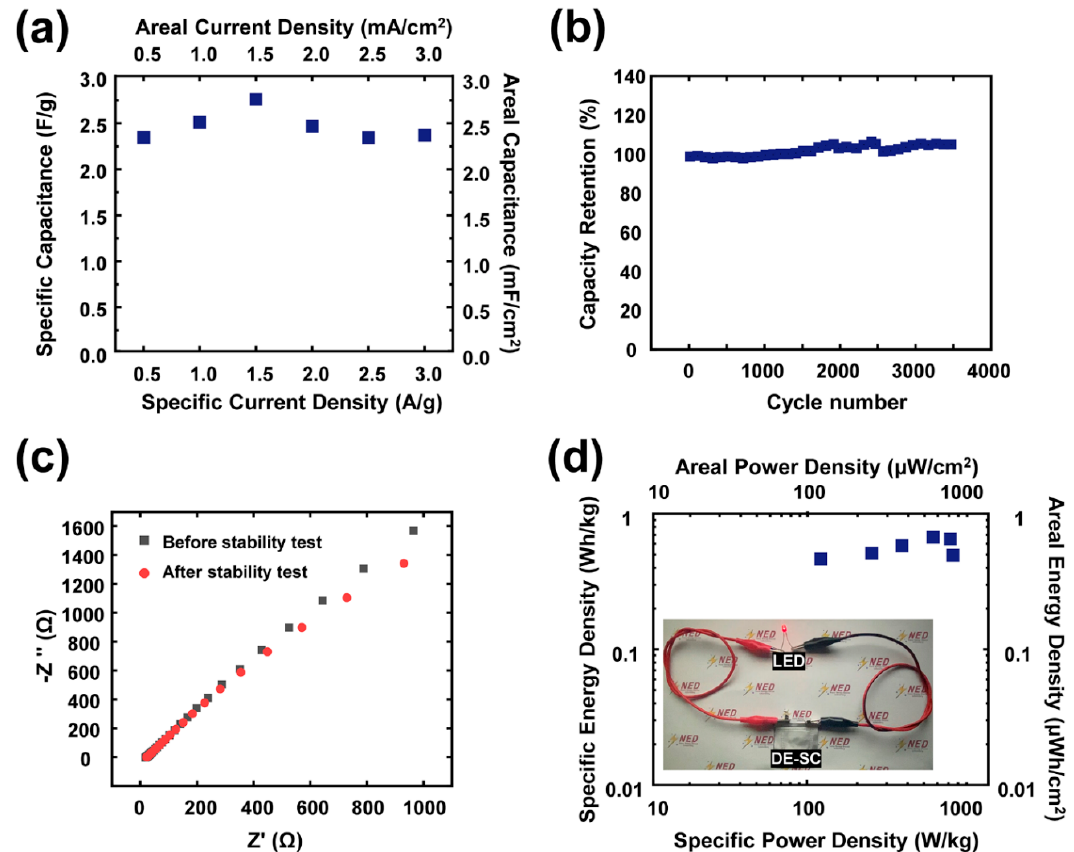
Figure 5. The electrochemical properties of the symmetric supercapacitor with DE. ( a ) The calculated specific capacitance and areal capacitance values. ( b ) The stability test for 3500 cycles from GCD curves and ( c ) the EIS curves before and after stability tests. ( d ) The energy and power densities of the symmetric DE-SC (inset image: showing the illumination of a commercial LED with the energy stored in DE-SC).